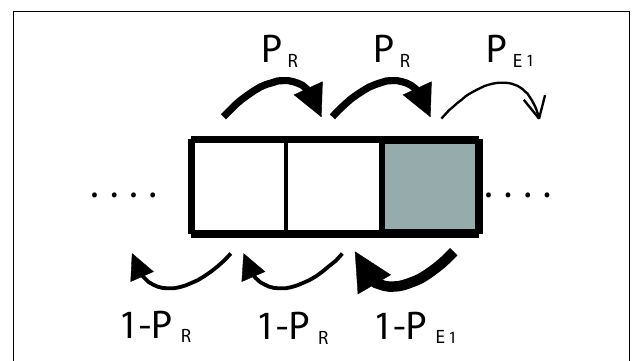
FIGUREA1 |A coupled (dual) agent-environment modeled through a Markov